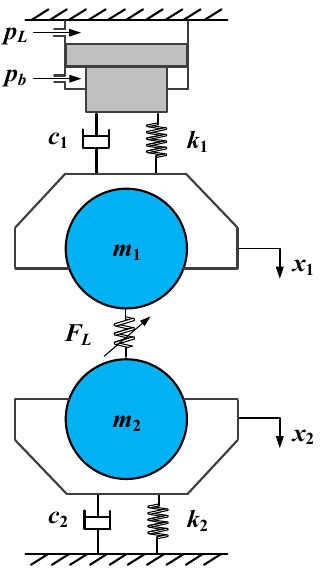
Figure 4. Two degrees of freedom mechanics model of the load roll system.